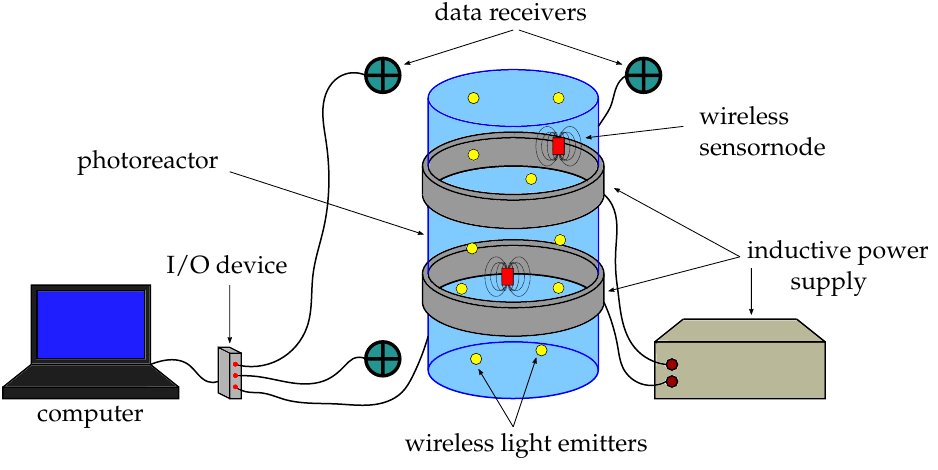
Figure 1. Conceptualization of an internal illuminated photoreactor expanded by a wireless sen- sor